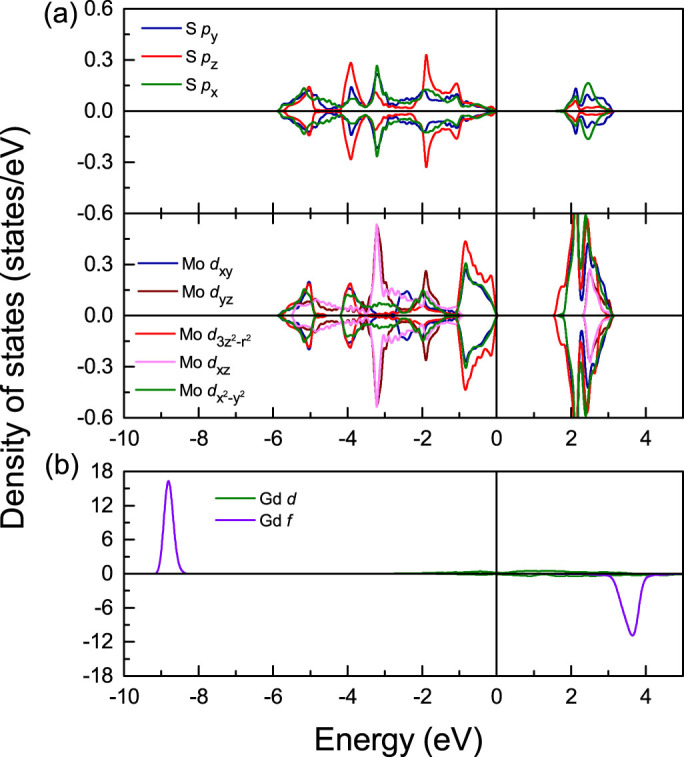
DOS of (a) the Mo and S atoms in pristine monolayer MoS2 and (b) the Gd atoms in bulk Gd.